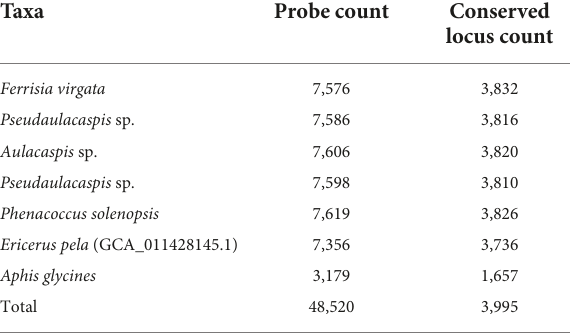
TABLE 4 Distribution of final probe